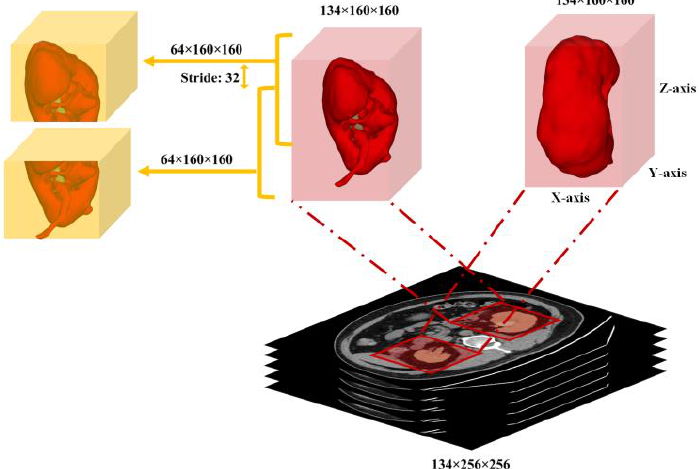
Figure 5. Each cropped cube with shape (1, 64, 160, 160) as input to the second segmentation network for fine kidney and stone segmentation.